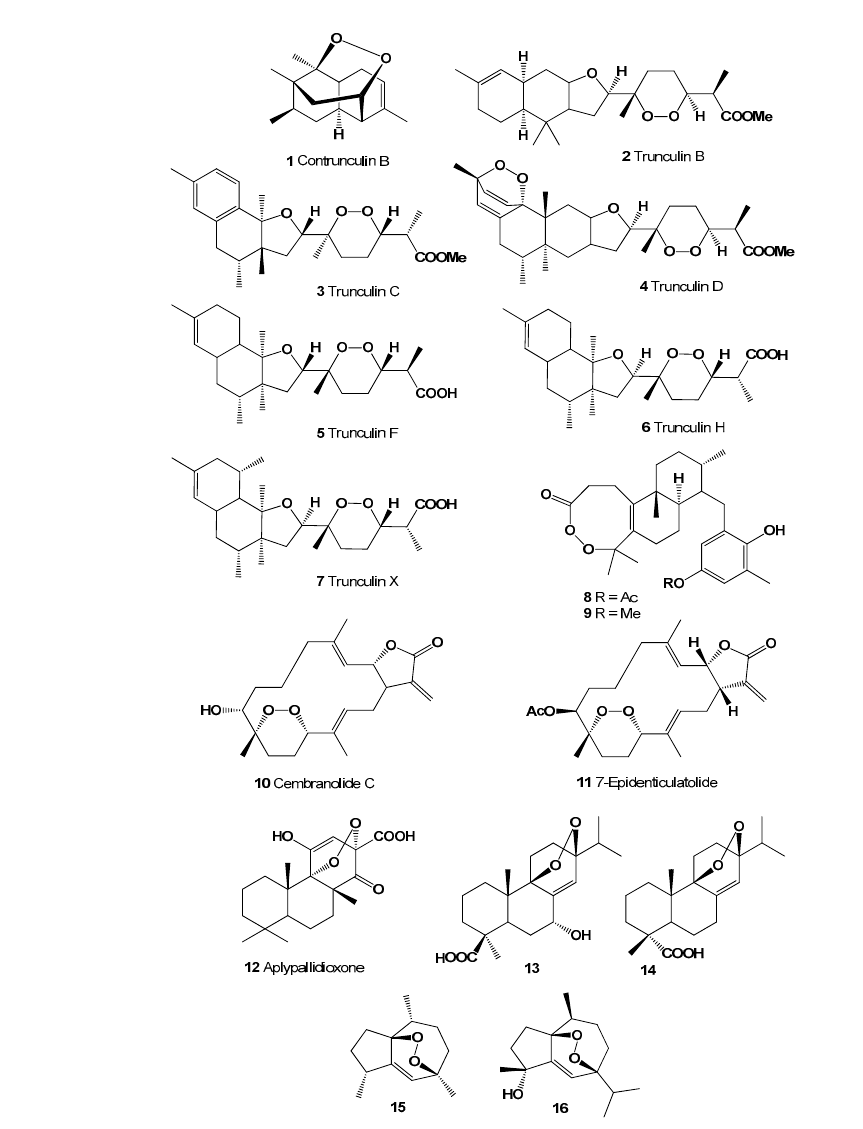
Figure 1. Bioactive polycyclic endoperoxides derived from marine sources.